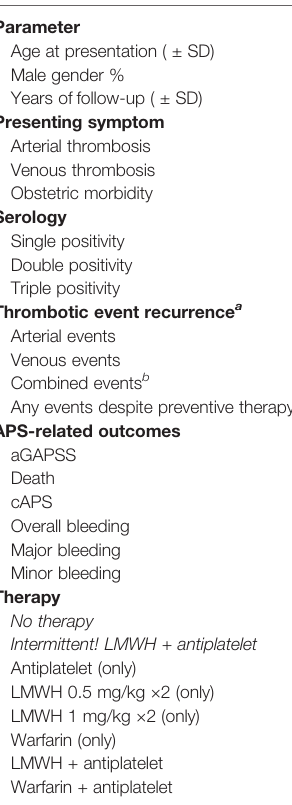
TABLE 1 | General features of patients with primary antiphospholipid syndrome.